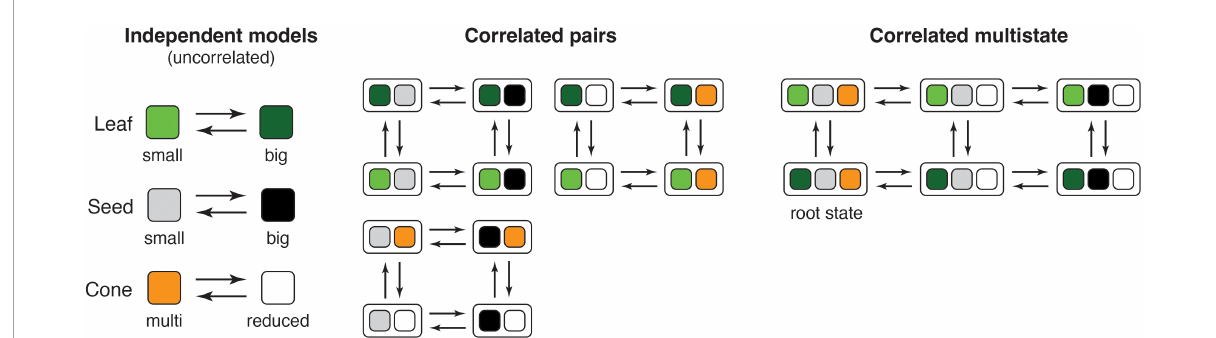
FIGURE1 Character models used in this study. Independent models treat each of the three characters (leaf size, seed size, and cone type) separately and fit transition rates to and from character states (arrows). We assessed correlated evolution of character pairs by fitting models that combine states from two characters (leaf size + seed size, leaf size + cone type, and seed size + cone type), and among all three characters (“correlated multistate”) by fitting models that encompassed all known state combinations (eight are possible but only the six shown occur in living taxa). Model fit and support were assessed by summing likelihoods from the independent models and comparing those to the relevant correlated